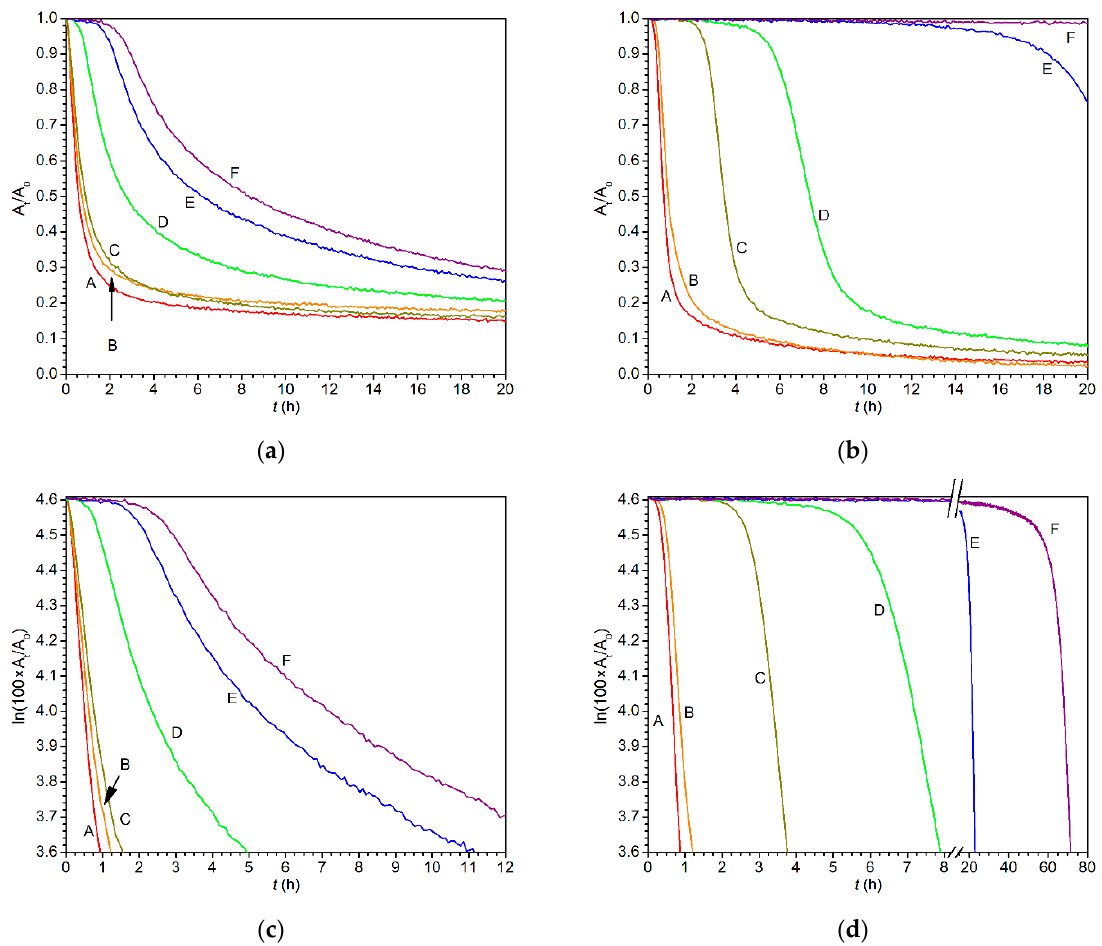
Figure 5. Time development of the infrared band ν a ( cis -C=C–H) of alkyd formulation S471 treated by: ( a ) Fe-diiPc in linear scale; ( b ) Co-2EH in linear scale; ( c ) Fe-diiPc in logarithmic scale; ( d ) Co-2EH in logarithmic scale. Metal concentrations for runs A–F are given in Table 5.